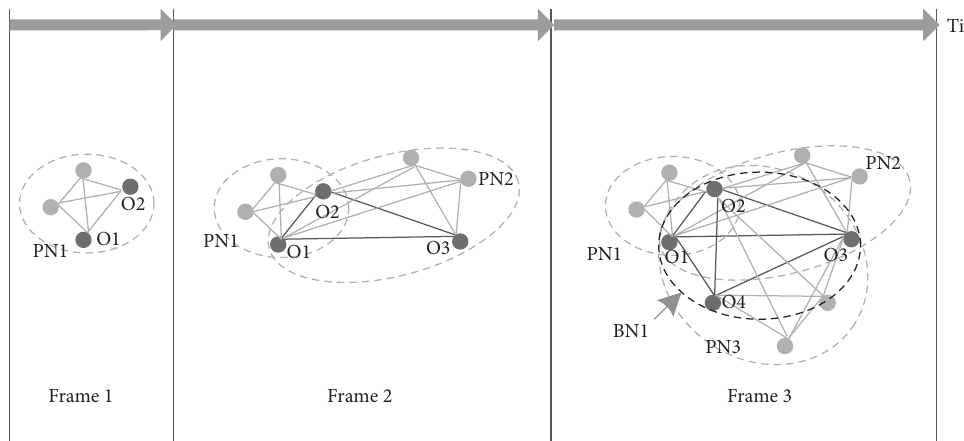
Figure 1: Formation process of project-based interorganisational collaboration business network. O represents organisation or participant, PN represents project network, and BN represents business